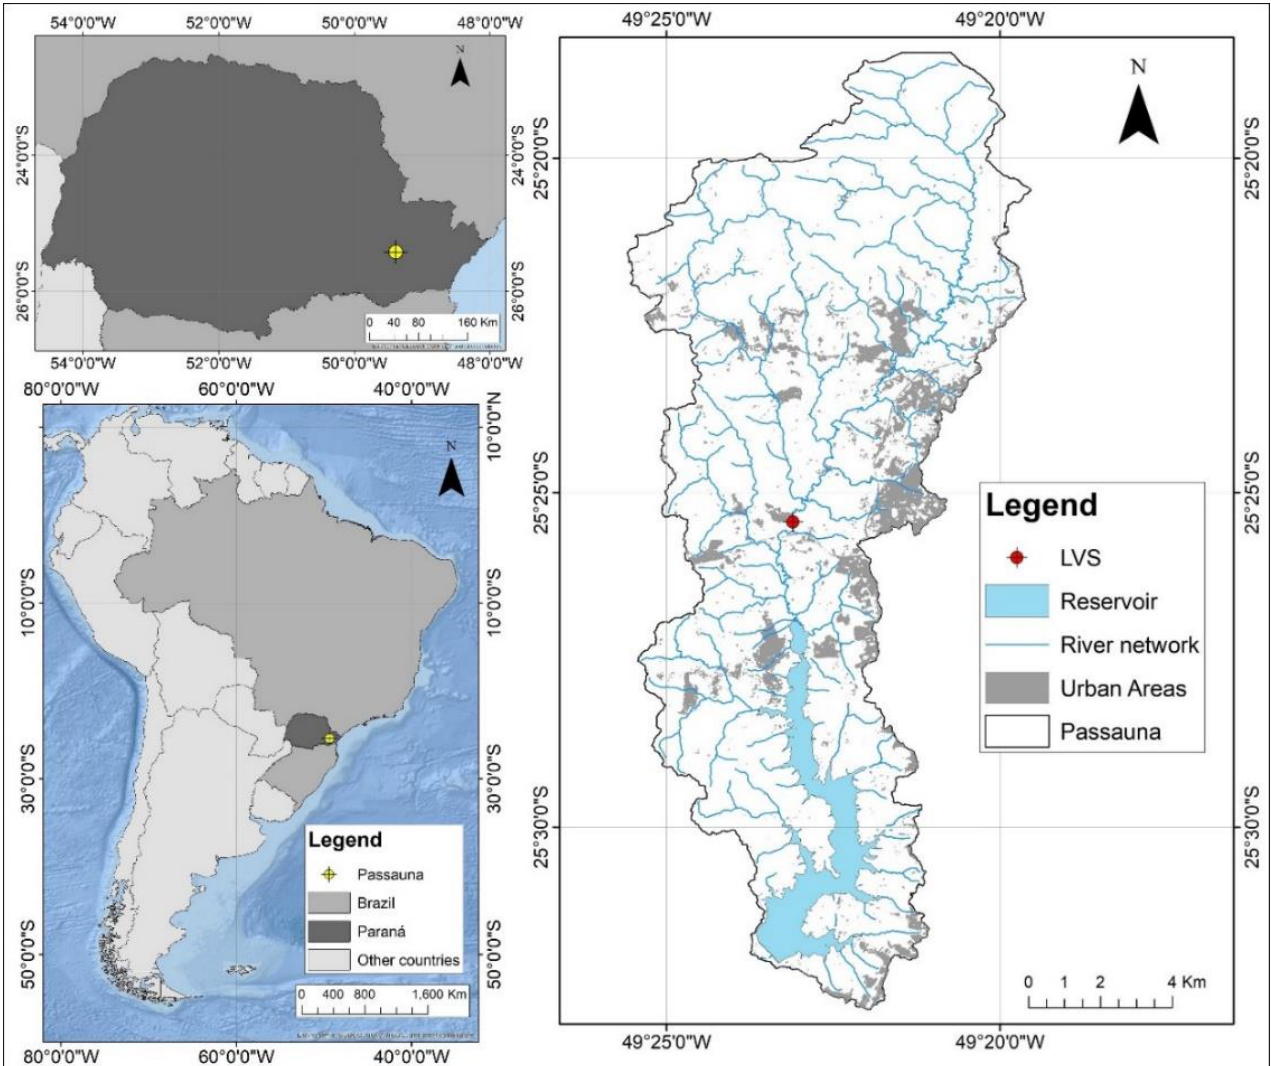
Figure 1. Location of the study area ( left ). Passaúna catchment and the coverage of urban areas in the catchment ( right ).